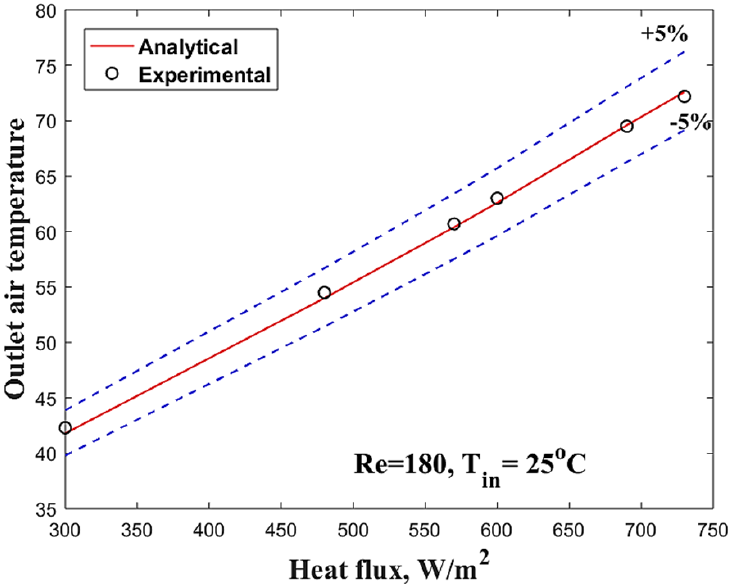
Figure 5. The comparison between the analytically calculated outlet air temperature and the experi- mental results at different heat fluxes.